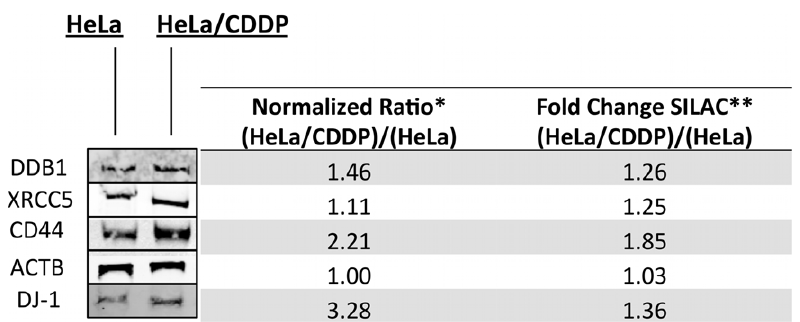
Figure 3. Western blot analysis. Cropped image of Western blot results comparing levels of four proteins (DDB1, Ku80, CD44, DJ-1) between HeLa and HeLa/CDDP. ACTB was also monitored as a quantitative control. * The normalized ratio for each protein was calculated by averaging the signal intensity from three biological replicates from HeLa/CDDP and dividing it by the average signal intensity from 3 biological replicates from HeLa. This ratio was then normalized using the average ratio of signal intensity of ACTB to the respective protein of interest band. In general there is good agreement between the ratios obtained from Western blotting and from SILAC. Full Western blot images are available in Figure S2 .